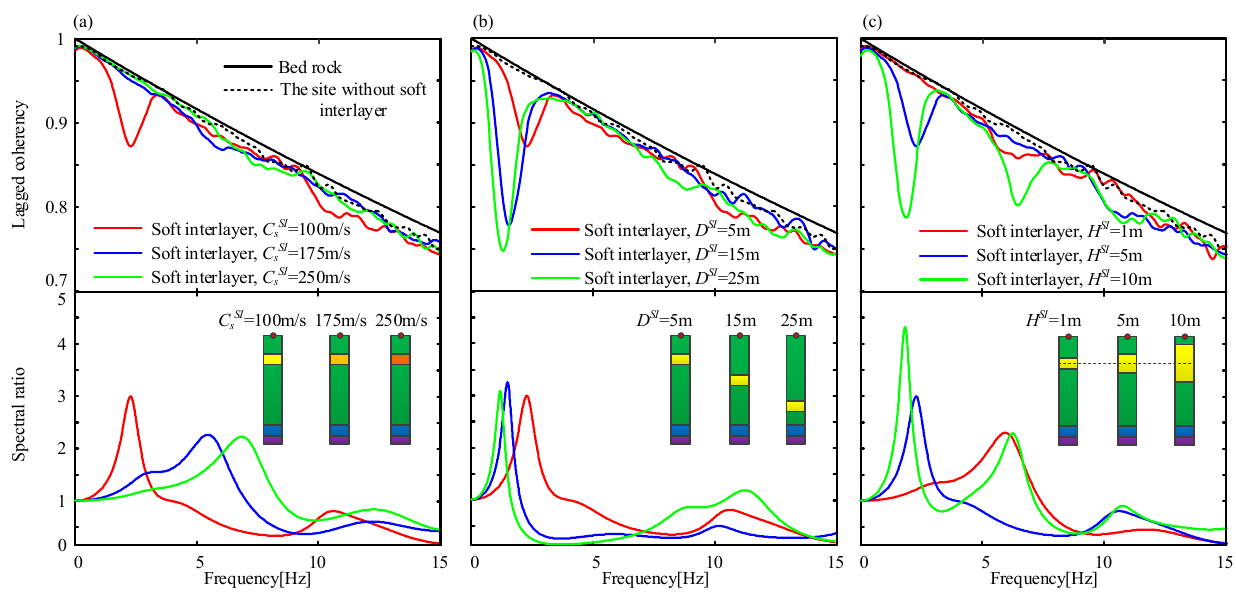
Figure 4. Mean lagged coherency between horizontal out-of-plane motions and corresponding spectral ratios for varying ( a ) shear wave velocity; ( b ) buried depth; and ( c ) thickness of interlayer.